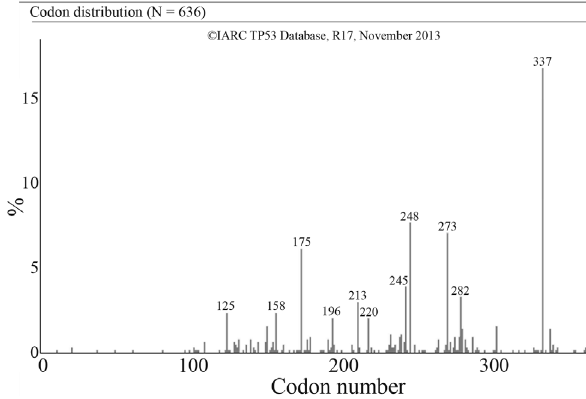
Figure 1 - Distribution of germline mutations in TP53 by codon (%). Among 636 families reported in the TP53 database, 107 (16.8%) harbor mutationsincodon337;ofthese,99mutations(92%)arep.R337H(From: IARC TP53 database, 17th